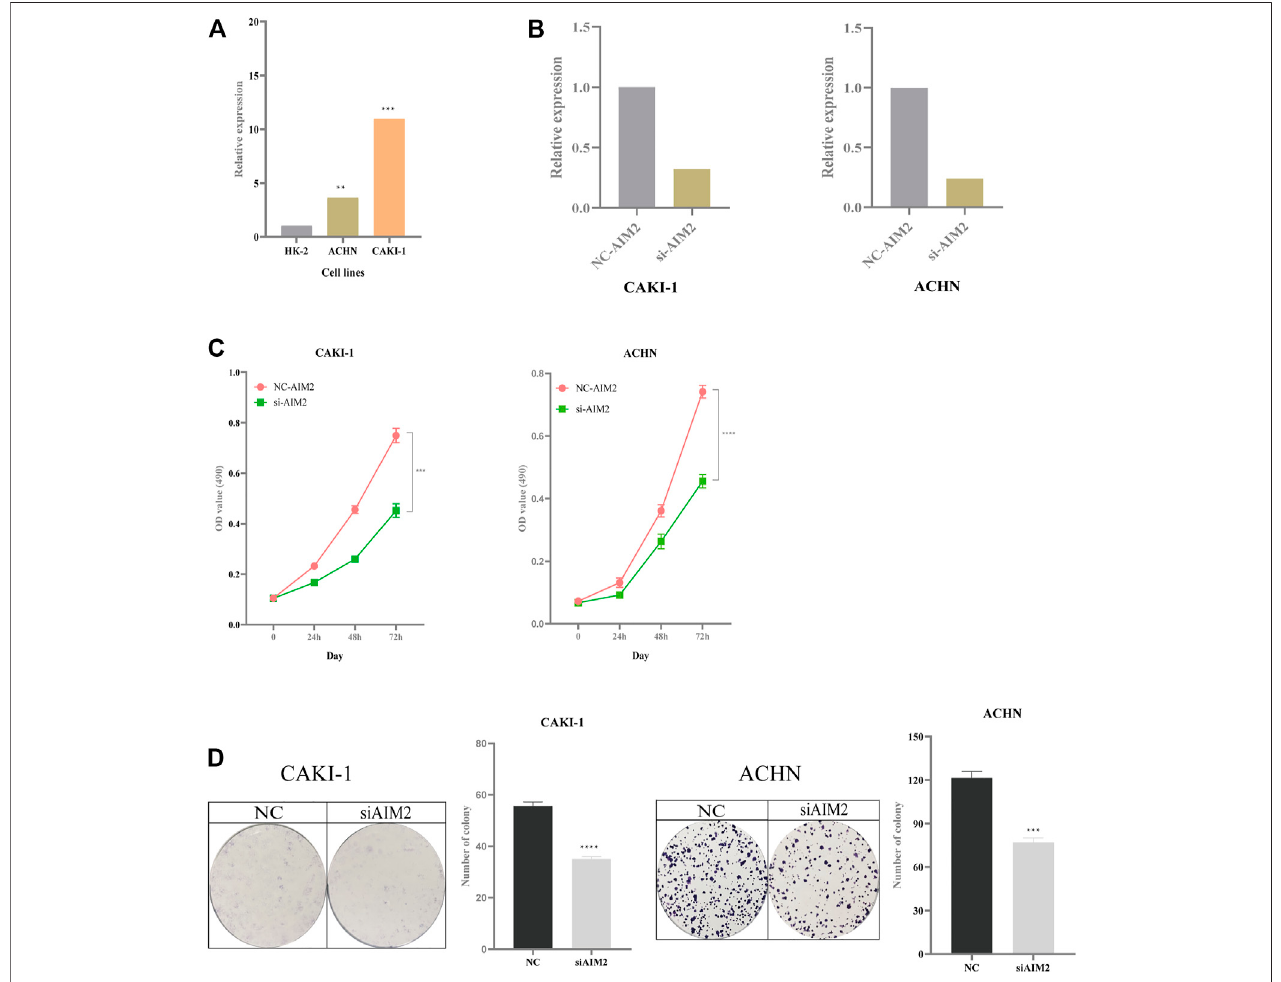
FIGURE 10 | Impact of expression of AIM2 on tumor proliferation. (A) The expression of AIM2 in normal and tumor cell lines. (B) In ACHN and CAKI-1 cells, the ef fi ciencyofknockdownofAIM2withsiRNA. (C) MTTassayswasperformedinACHNandCAKI-1cellstransfectedwithAIM2siRNAandnegativecontrolsiRNA.Tumor cell transfected with siRNAs were six replicates, respectively. (D) Colony formation assays in ACHN and CAKI-1 cells transfected with AIM2 siRNA and negative control siRNA. Tumor cell transfected with siRNAs were three replicates, respectively. The data were shown as the means ± SD. p -values were calculated by t-test. * p < 0.05; ** p < 0.01; *** p < 0.001; **** p <